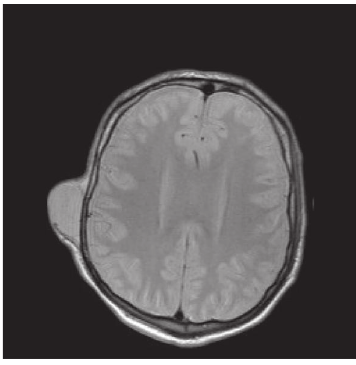
Figure 5: MRI (axial view) showed the subcutaneous temporal metastasis with intact underlying